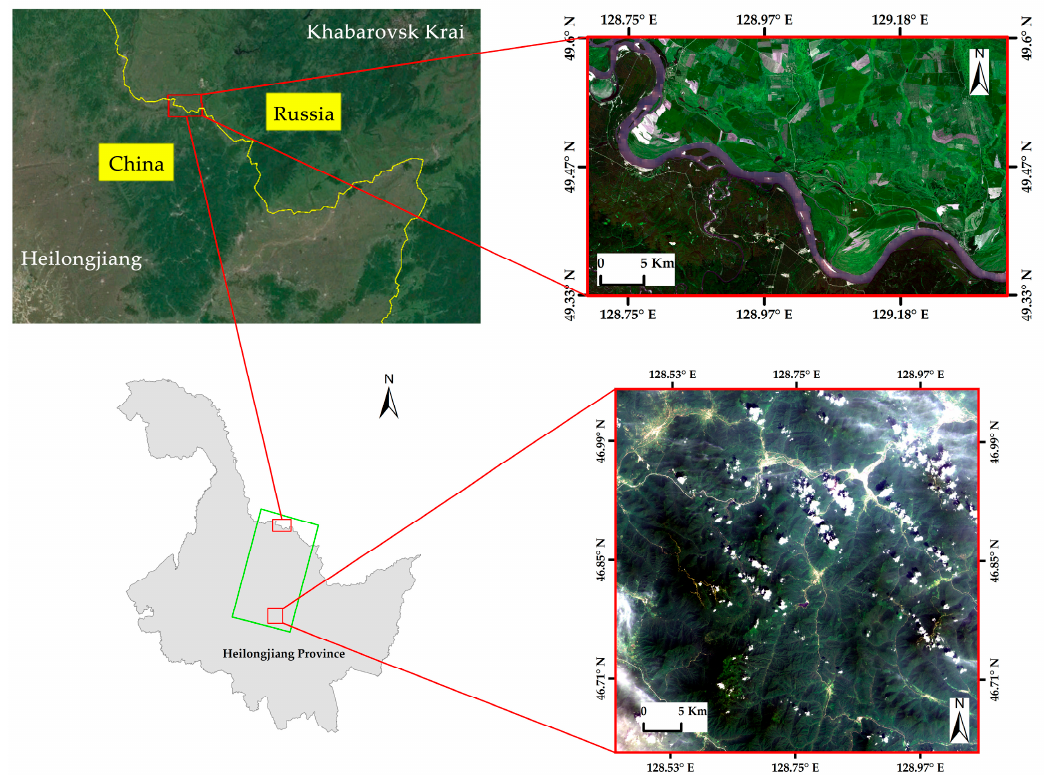
Figure 3. Location map of the research area (source: shape file for China and Google Earth) and red-green-blue composites of Landsat 8 OLI images in two sub research areas (upper: the first sub region, lower: the second sub region). The two RGB images are extracted from two satellite images with the same path but different rows acquired on 9 August 2014 (upper: 117/26 (path/row), lower: 117/27). The green rectangle in the lower left side shape file is path/row scene mosaic boundary.